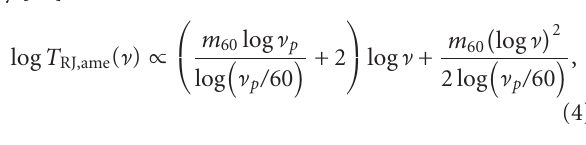
of 2.726 K ([27]); for free-free we used the model T RJ, ff ( ν ) ∝ G × ( ν / 10) − 2 where G = 3 . 96( T